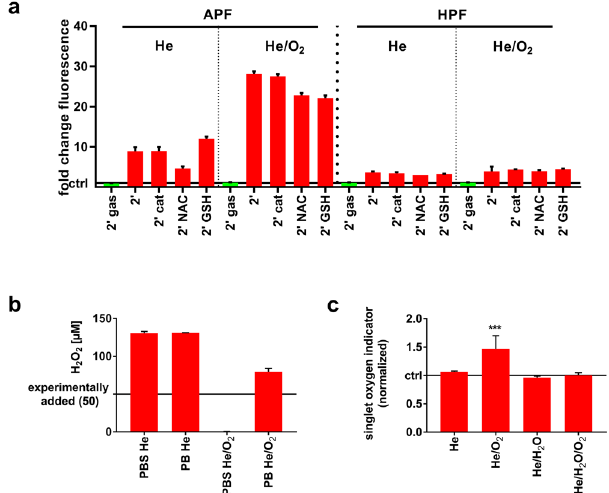
Figure 5. He/O 2 plasma generated hypochlorous acid in the liquid via gaseous phase oxygen species. ( a ) Cell culture medium as loaded with either APF or HPF. Scavengers were added or not, solutions were plasma-treated using either He or He/O 2 as feed gas, and fluorescence of the redox dyes was acquired which was normalized to each respective gas control. APF in general gave a stronger fluorescence signal which was increased in the He/ O 2 condition but not using the He plasma. NAC partially scavenged signals. ( b ) Fifty micromolar H 2 O 2 was added to PBS and chloride-free phosphate buffer (PB). Solutions were plasma-treated using either He or He/ O 2 plasma. The latter scavenged experimentally added H 2 O 2 in PBS but not PB. ( c ) Singlet oxygen sensor green was added to cell culture medium which was subsequently exposed to either He, He/O 2 , He/H 2 O, or He/H 2 O/ O 2 plasma. Fluorescence was acquired and normalized to untreated gas control, and only He/O 2 plasma differed significantly. Data are presented as mean + S.D. of two experiments. Statistical difference ( *** p < 0.001) was determined using t-test.